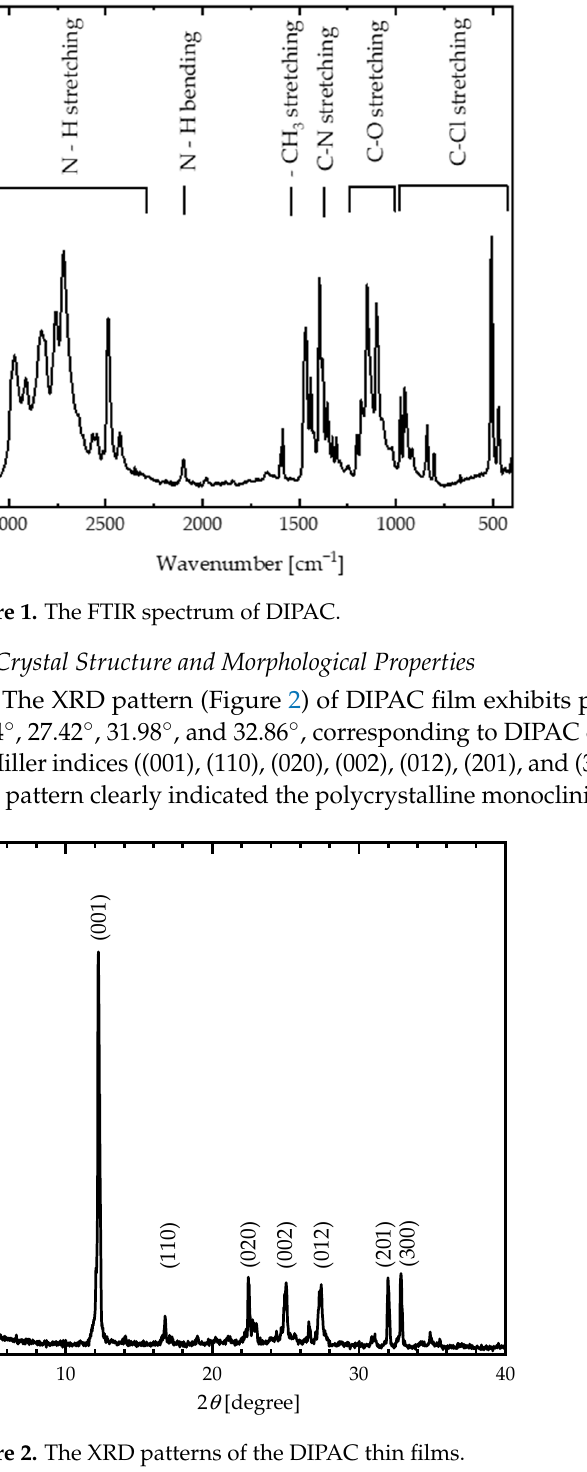
Figure 2. The XRD patterns of the DIPAC thin films. The monoclinic structure of the DIPAC molecular crystal was also determined by DFT-based calculations, with lattice constants of a = 7.495 Å, b = 7.818 Å and c = 7.655